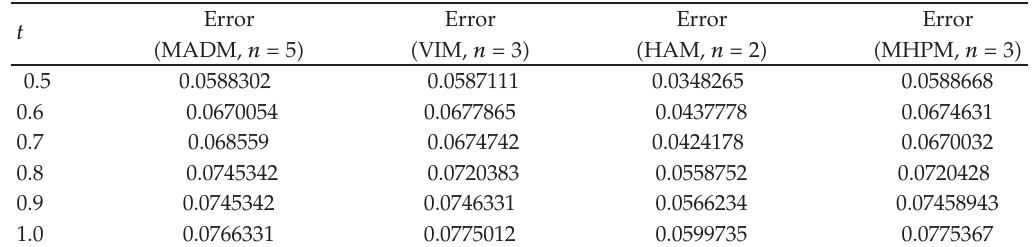
Table 1: Numerical results of Example